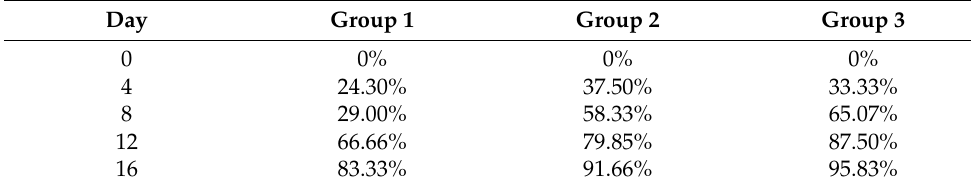
Table 2. The effect of quercetin glycoside on excision wound [% wound